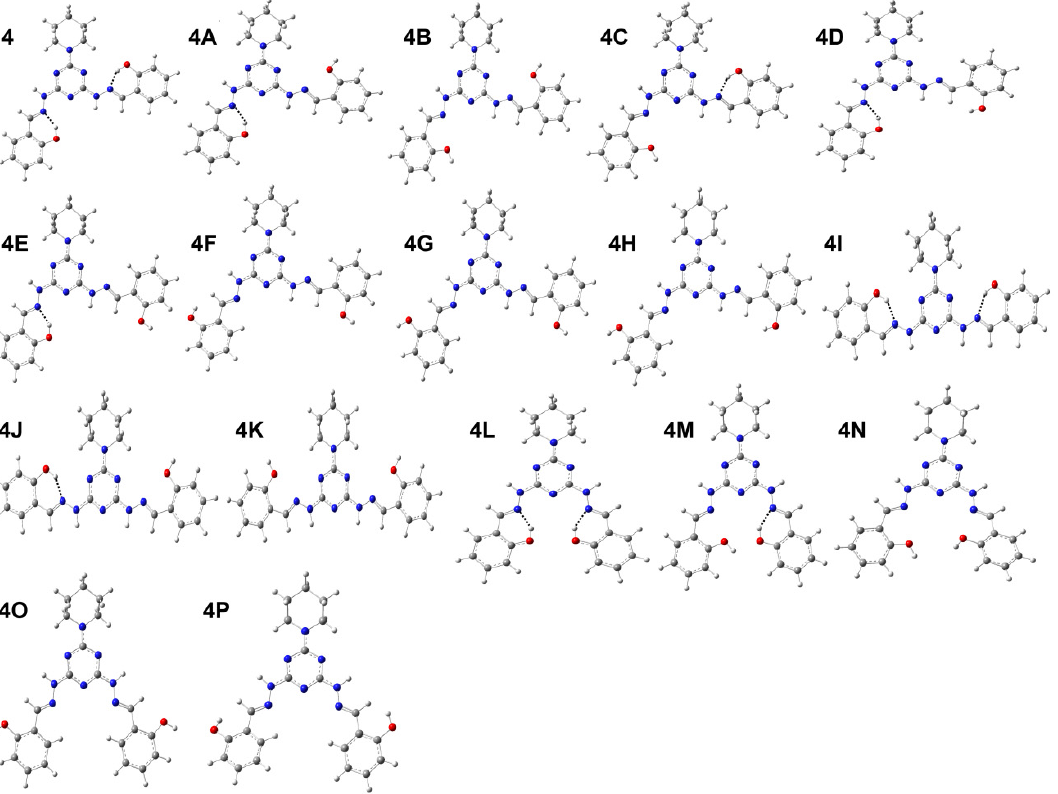
Figure 8. The optimized geometries of the suggested conformers of 4 . The intramolecular O-H…N hydrogen bonds are presented by black dotted line. Table 5. The calculated energies and thermodynamic properties of the studied conformers. Param .